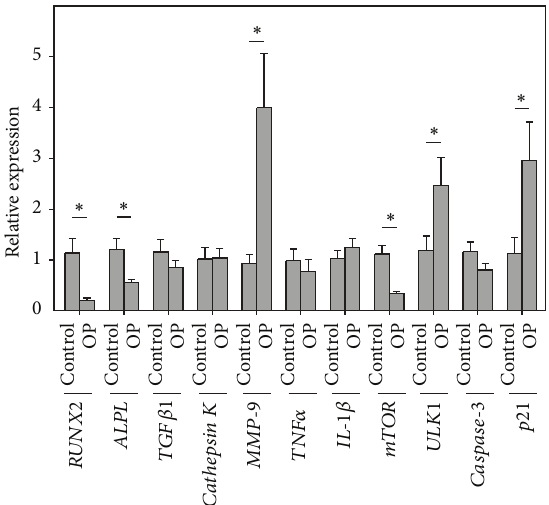
Figure 1: Relative expression of RUNX2, ALPL, TGF 𝛽 1, cathepsin K, MMP-9, TNF 𝛼 , IL-1 𝛽 , mTOR, ULK1, caspase-3, and p21 genes with reference to 𝛽 -actin gene in the peripheral blood of 22 postmenopausal OP patients compared to 26 healthy age-matched control women (control). Each point represents the mean ± SD. Significant differences as compared to the control are indicated by